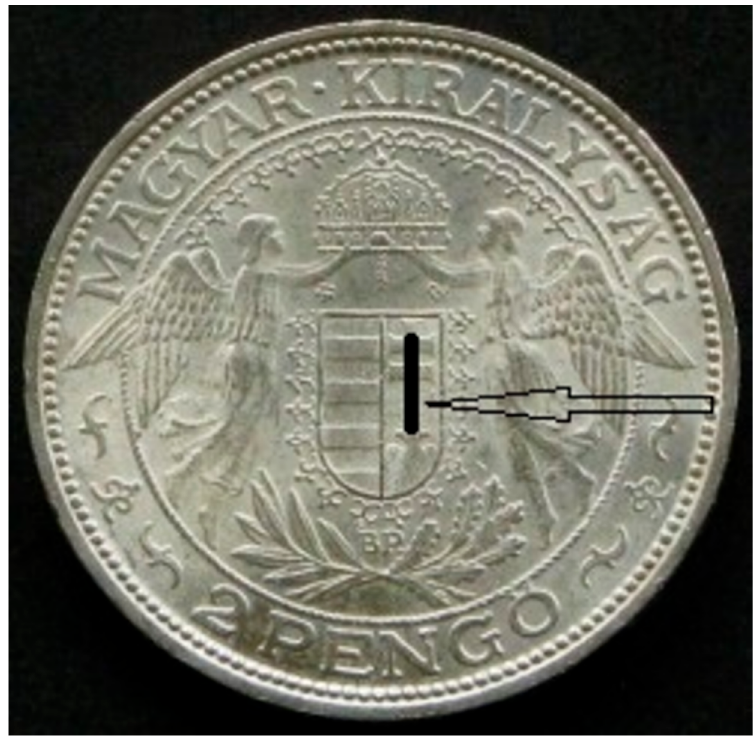
Figure 1. The place of measurement for sample No. 13.